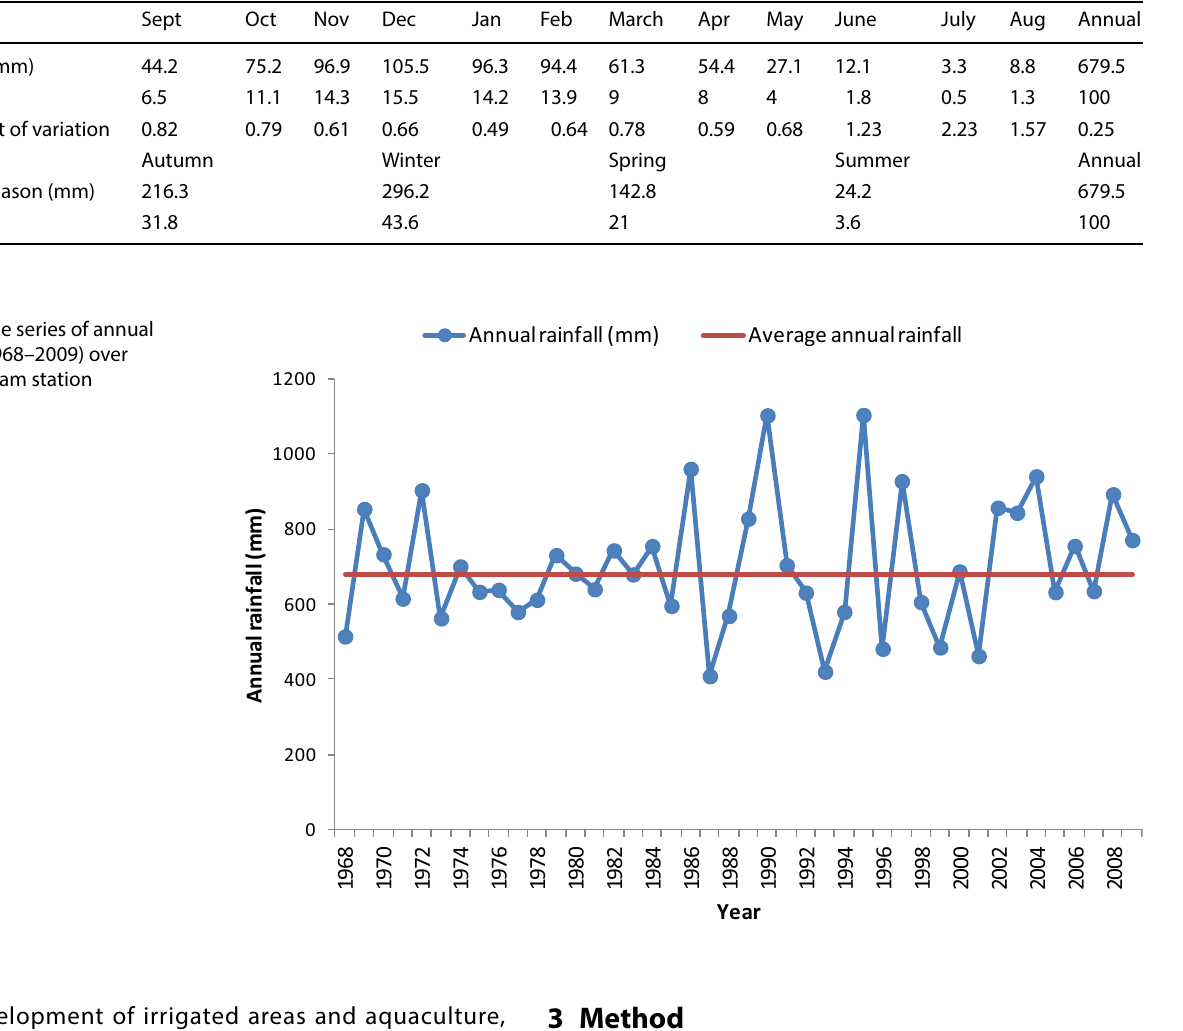
Table 2 Monthly and seasonal distribution of annual rainfall at Ghèzala Dam station